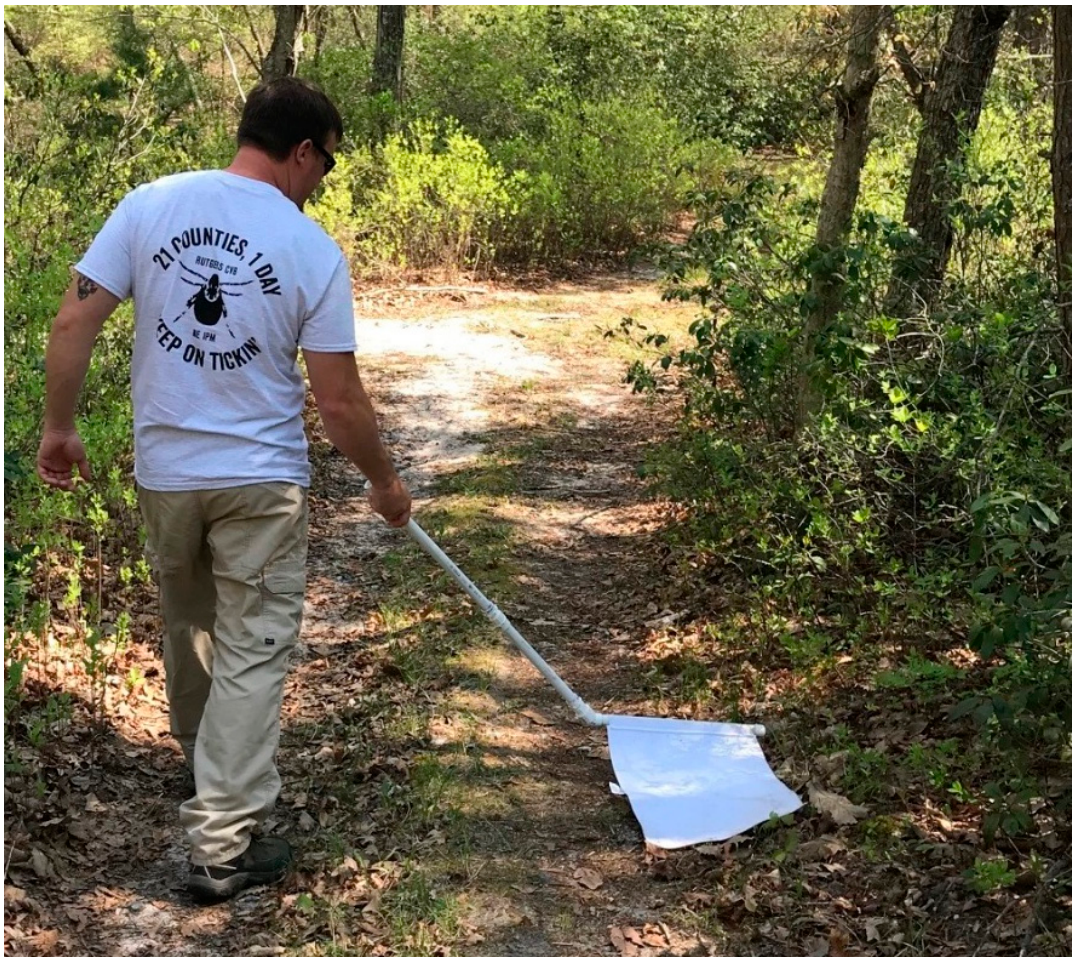
Figure 2. New Jersey (NJ) Tick Blitz participant using provided tick sweep. Original design by [49] with modifications by Benedict Pagac and James Butler. Photo courtesy Jonathan Cassidy and Joe New, Burlington County, NJ.